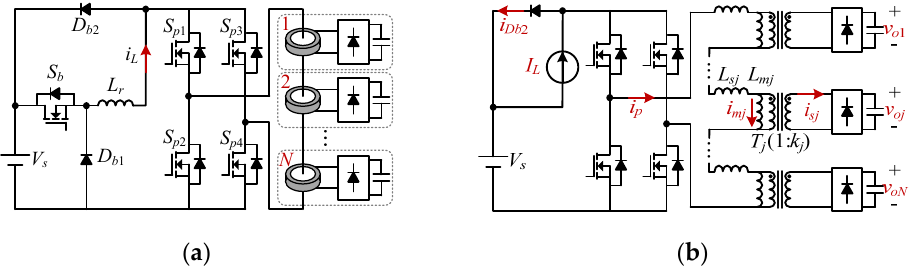
Figure 1. The topology and equivalent circuit of the APS. ( a ) Topology of the APS. ( b ) Equivalent circuit of the APS.